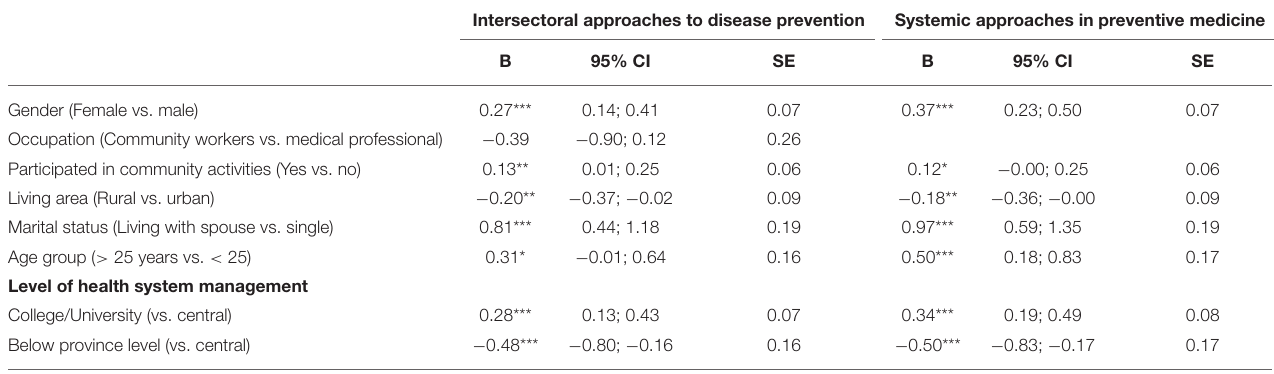
TABLE 4 | Demographic factors associated with disease control priorities among health workers and medical students in Vietnam,